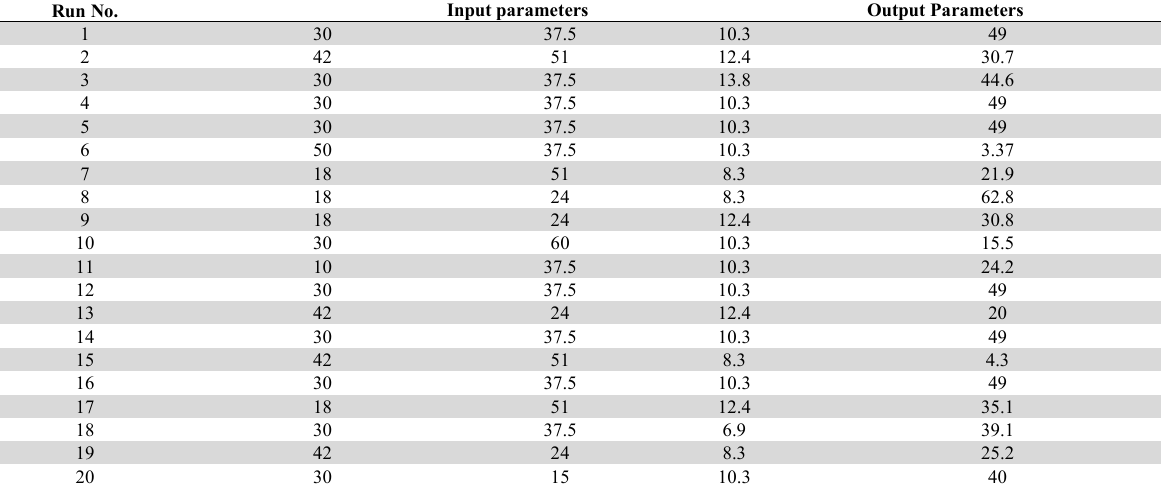
Experimental results Run